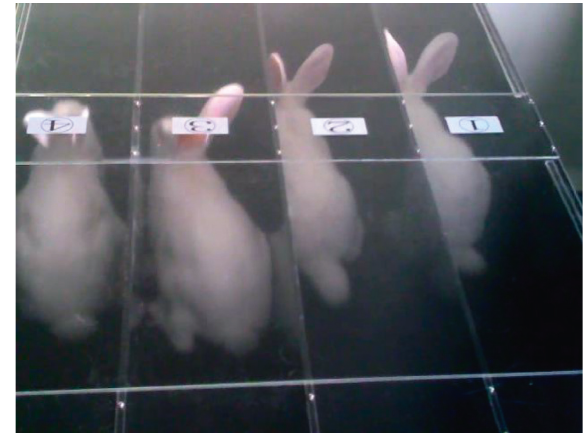
Figure 1: Four rabbits running on the treadmill at the same